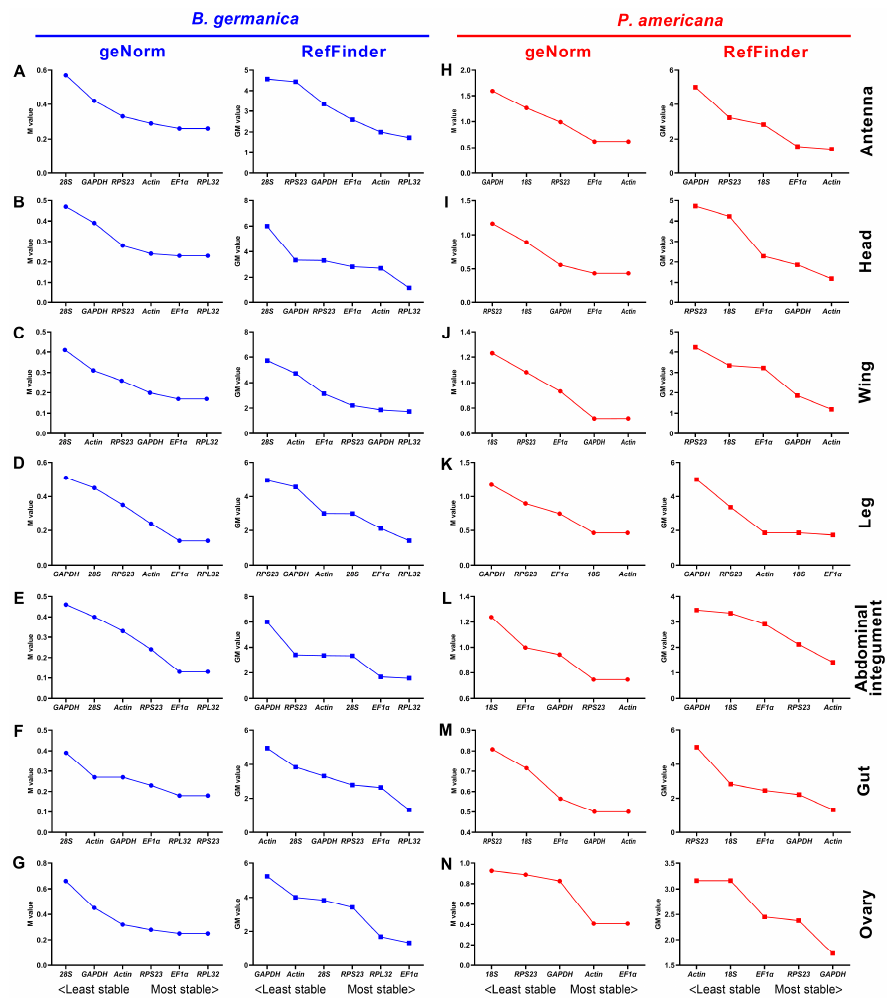
Figure 2. Expression stability rankings of candidate reference genes across different developmental stages in specific tissue types. The M and GM values were calculated by the geNorm and RefFinder algorithms, respectively, for candidate reference genes across different stages in the tissue of antenna, head, wing, abdominal integument, gut, and ovary in either B. germanica ( A – G ) or P. americana ( H – N ) .